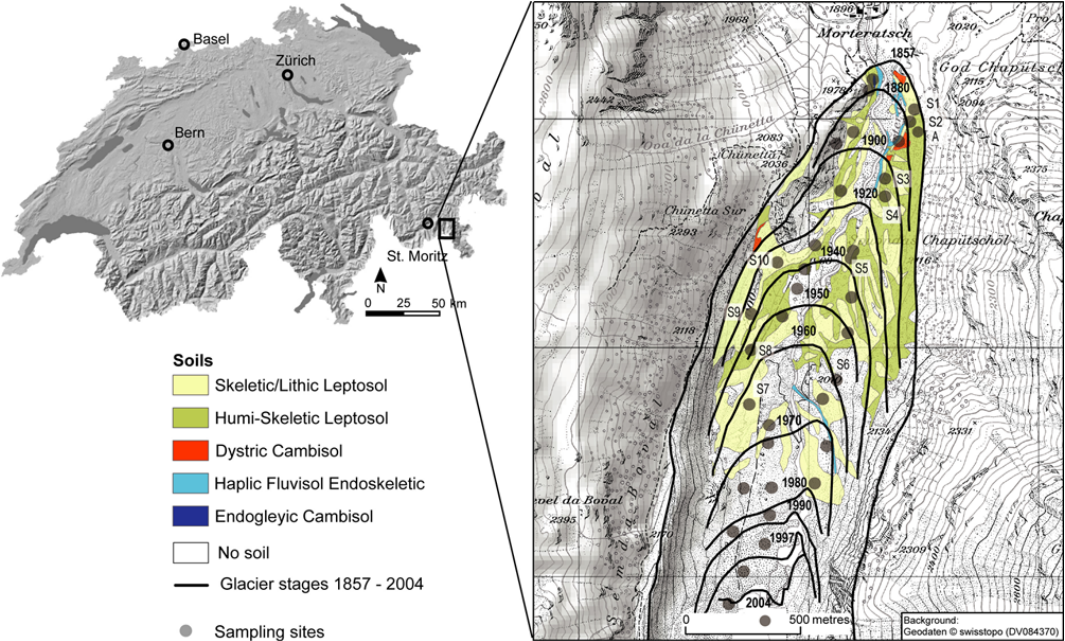
Fig. 1. Location of the Morteratsch glacier forefield with isochrones of glacier retreat, major soil units and position of the topsoil sampling sites, which were analysed in detail regarding soil chemistry and mineralogy (S1–10; Mavris et al.,